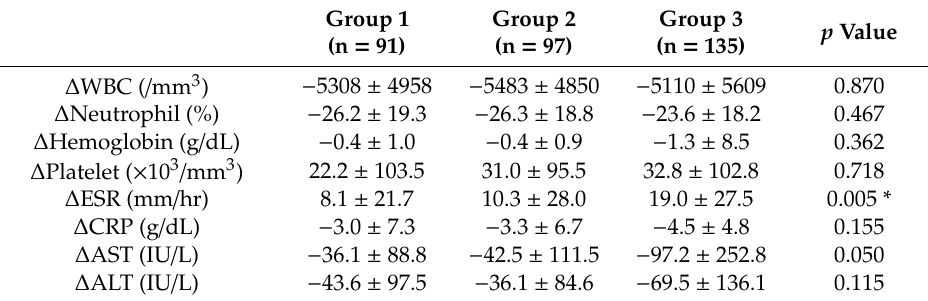
Table 3. Comparison laboratory changes among